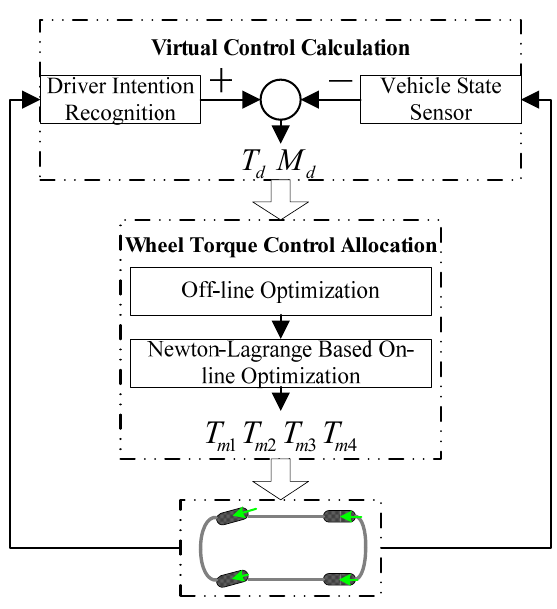
Figure 2. The wheel torque control strategy for